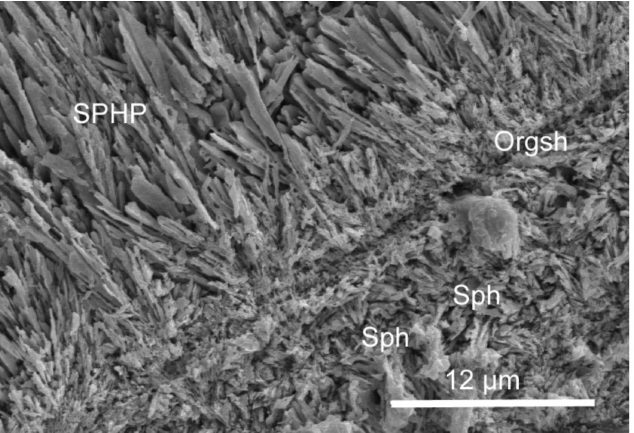
Figure 7. Longitudinal section through the tube of Glomerula piloseta . SPHP—spherulitic prismatic structure (inner layer). Orgsh—organic sheets. Sph—spherulites (external